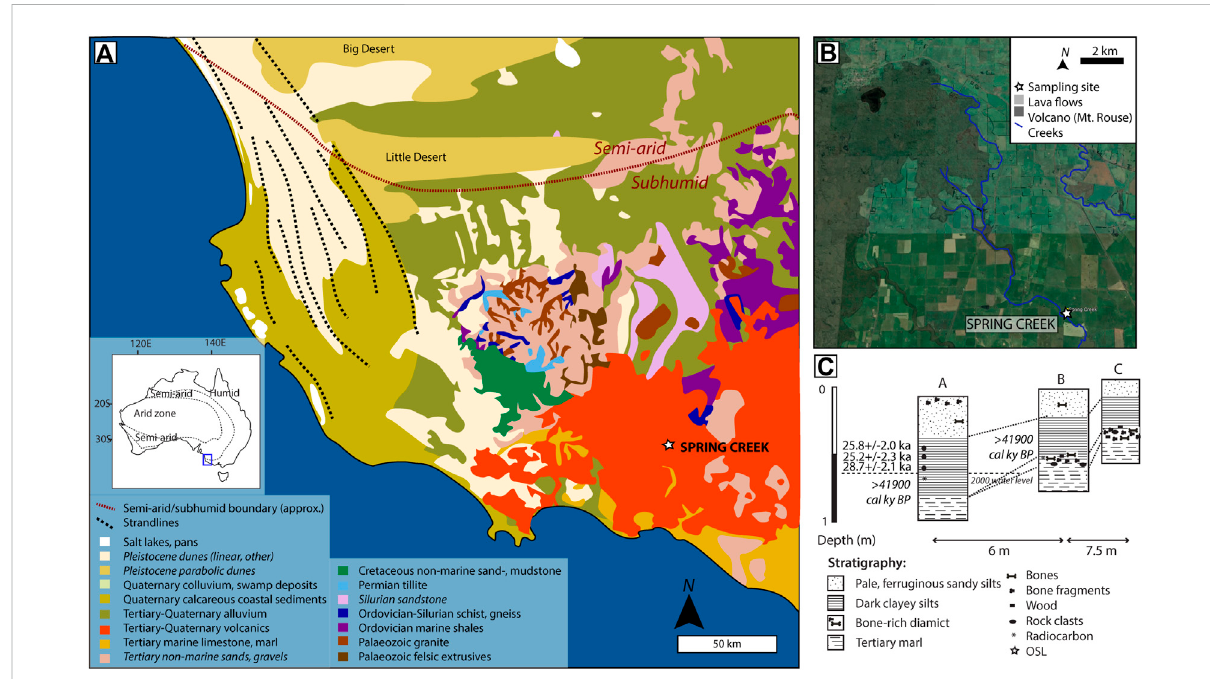
FIGURE 2 Location,geologicalcontextandchronologyoftheSpringCreekarea. (A) LocationofSpringCreekinsoutheasternAustralia(inset)withrespect to geology (Geological Survey of Victoria, 1982) and the approximate PD semi-arid/subhumid boundary (source: Bureau of Meteorology). Pleistocene strandlines and possible sources of sand which may have been transported to Spring Creek are shown in the legend in italics. (B) Local context of the Spring Creek site, showing the volcano Mt. Rouse and its most recent associated lava fl ows to the north and west, and the catchment of Spring Creek draining the basaltic surface. Base image sourced from Google Earth. (C) Stratigraphy and chronology of the sampled sections at Spring Creek, including stratigraphic setting of the bone diamict, OSL ages and summarized 14 C